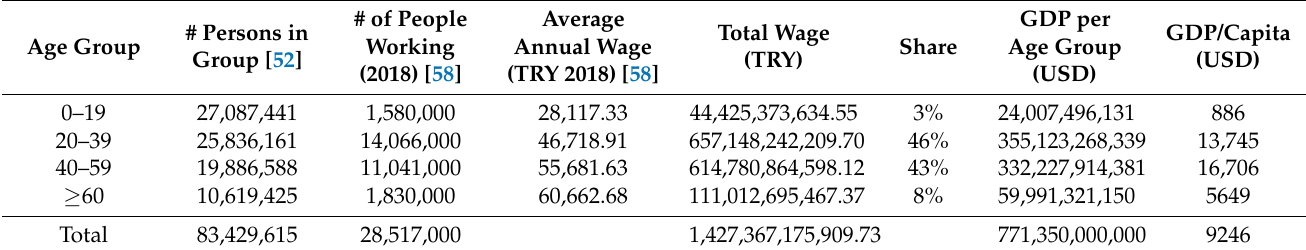
Table A2. GDP/capita calculation per age group in Turkey estimated by using the share of the total wage to redivide the GDP by age